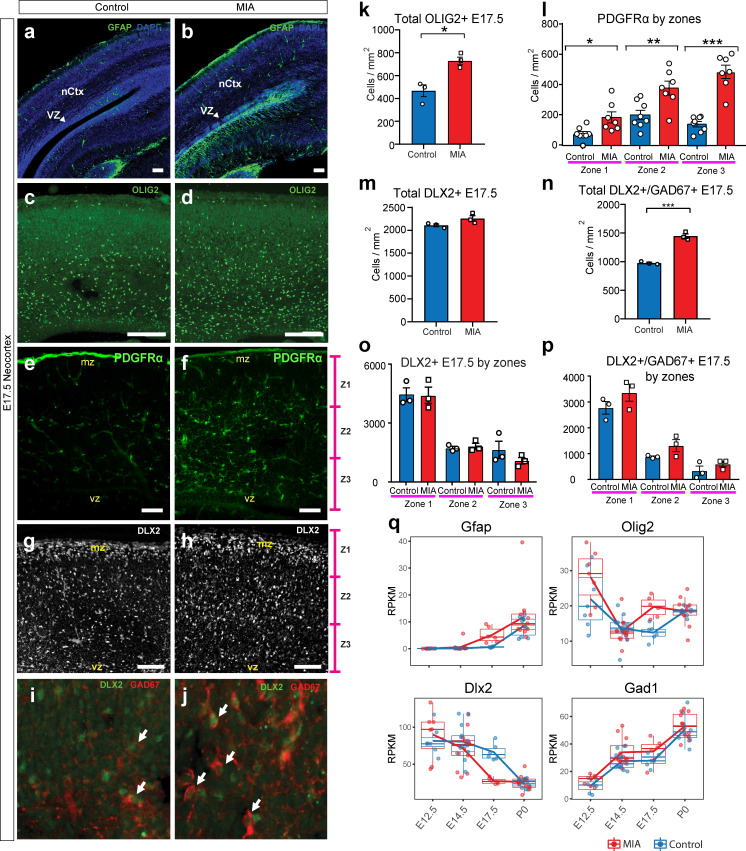
MIA alters development of neuronal and glial cell types in fetal offspring at E17.5.(a–j) Coronal fetal brain sections from three independent E17.5 saline litters (n = 4 control) and four independent MIA litters (n = 6 MIA) were immunostained for cell-type markers. (a,b) Altered distribution and numbers of GFAP+ cells (radial glia and astrocytes) in MIA samples. (c-j) Reduced sub-population of interneurons and oligodendrocytes using OLIG2, PDGFRα, DLX2, and GAD67. (k-p) Quantification of the cell density in (c-j). Overall MIA-associated increase in OLIG2+ cells (k), with further specific increased PDGFRα+ cells representing oligodendrocytes (l), and no change in overall DLX2+ interneurons (m,o), but increased overall number of DLX2+/GAD67+ interneurons (n,p) are observed in MIA neocortex. Student’s t-test: OLIG2 p=0.0134; DLX2+/GAD67+ cells p=0.0004. Bin quantification analyses of PDGFRα+, DLX2+, and GAD67+ immunoreactive cells in zones 1–3 (Z1 to Z3) indicate that changes are not restricted to a particular zones of the neocortex. Arrows denote co-labeled cells. Scale bars in (a-h) = 100 µm and in (i-j) = 30 µm. Abbreviations: neocortex (nCtx); marginal zone (mz); ventricular zone (VZ). (q) RPKM trajectories of the cell identity markers tested in (a-k) across the developmental time-points of the study show parallel differences in mRNA expression of cell-type markers following MIA induction. Gfap and Olig2 mRNA was significantly upregulated in MIA samples at E17.5. Dlx2 was significantly downregulated at E17.5, with no significant changes observed for Gad1 (encodes GAD67) or for Pdgfra (not shown).